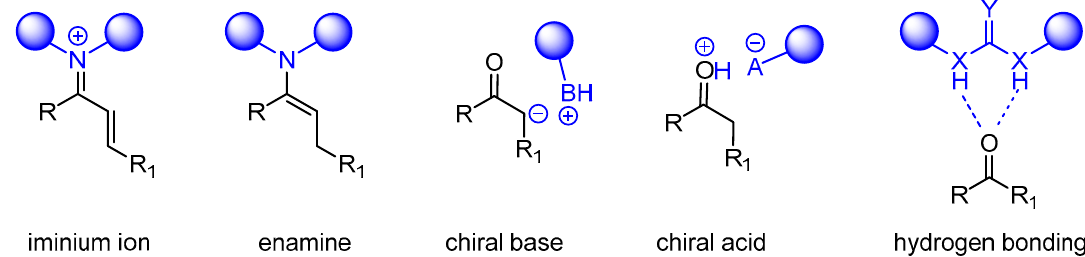
Figure 1. Di ff erent methods of substrate activation. Figure 1. Different methods of substrate activation. Figure 1. Different methods of substrate activation.